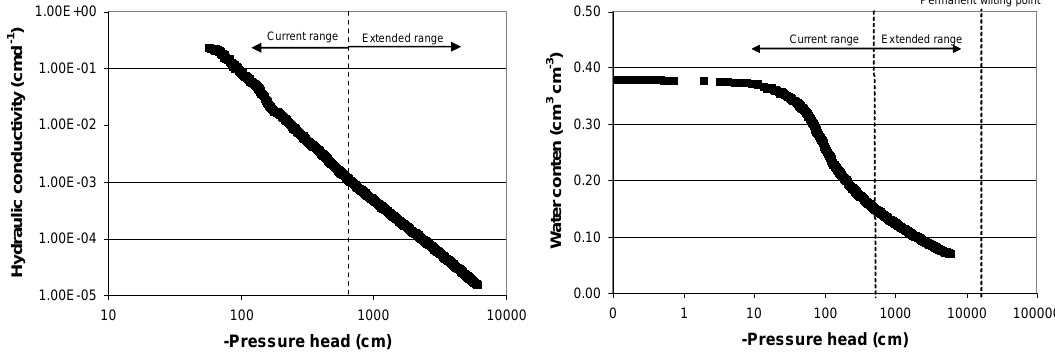
Figure 3. Extended hydraulic functions measured with the evaporation method. Sandy loam, Dedelow, Uckermark (Germany). method while maintaining the same quality of